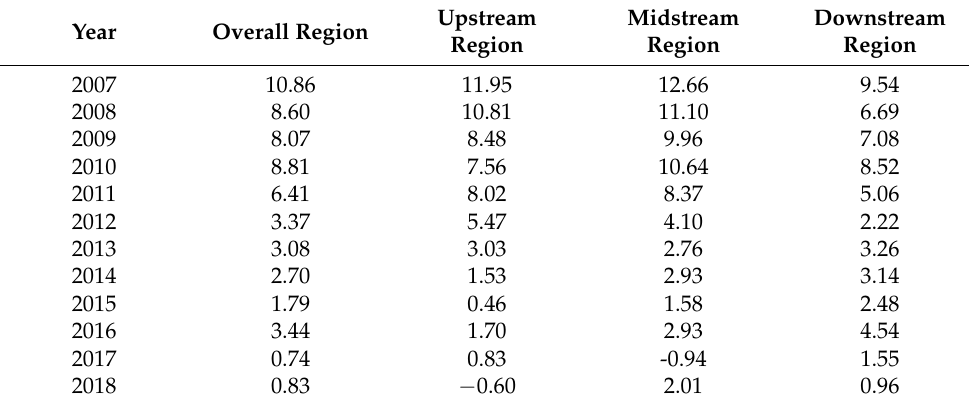
Table 2. The TFP growth rate ( tfp ) of the Yangtze River Economic Belt from overall region, upstream region, midstream region and downstream region from 2007 to 2018 (unit: %).